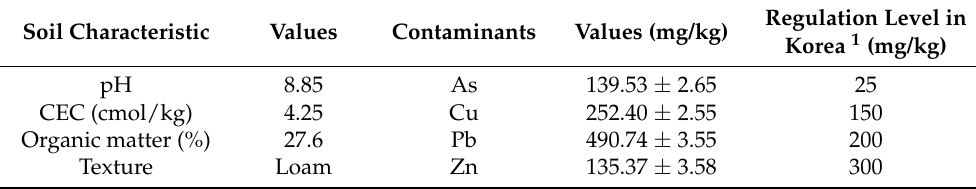
Table 1. Physicochemical characteristics of the contaminated